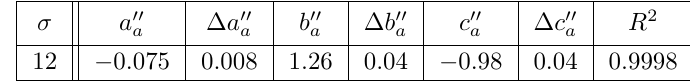
Table 14 . Parameters of the fit (4.6) with respect to α a for resonance parameter σ = 12 and maximum temperature exponent α respectively. R 2 is the R-squared goodness of the a 00 , b 00 , c 00 a a a